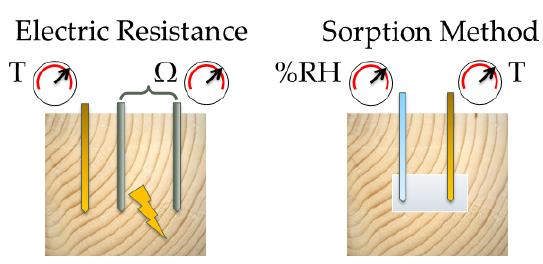
Figure 4. The resistance method, in which resistance and temperature need to be measured, and the sorption method, in which the climate in a small cavity is measured.